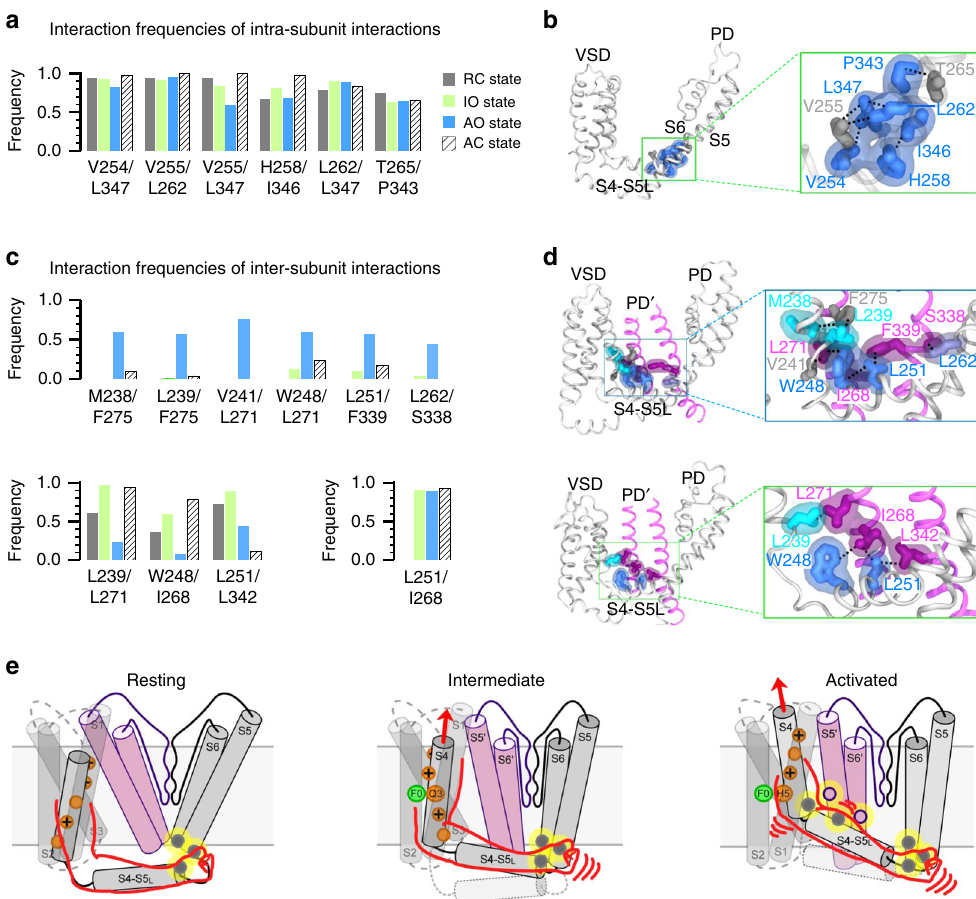
Fig. 5 MD simulation correlates temporal sequence of VSD movement to engagement of the two-stage E – M coupling interactions. a Interaction frequencies of K V 7.1 residue pairs as observed during the MD trajectories for the K V 7.1 RC, IO, AO, and AC models. Frequency threshold of 0.4 or higher is de fi ned as indicative of interaction between two residues (see Methods). b Representations of the IO state model of a K V 7.1 subunit. Inset: enlarged structures of the boxed area. Blue, residues identi fi ed as important for E – M coupling in experiments (Fig. 1c – g); gray: V255 and T265, which were identi fi ed in MD simulations, but for which mutations still show functional currents (Fig. 3c). Residue V255 was found to be important for the AO state E – M coupling (Fig. 3). Each pair of residues is represented by a black dashed line connecting their respective sidechains. c Interaction frequencies of AO model-speci fi c (top), IO model-speci fi c (bottom left), and in both IO and AO models (bottom right) residue pairs during the MD trajectories. d Representations of the AO (top) and IO states (bottom) models of K V 7.1. An entire subunit (in gray) as well as S5' and S6' segments of an adjacent subunit (in purple) are shown with insets of enlarged structures of the boxed area. Residues important for E – M coupling in experiments (Fig. 3) and involved in residue pair interactions in MD simulations are colored similarly as in Fig. 3h: cyan, residues in S4c; blue: S4-S5L, and purple: S5 and S6 from the adjacent subunit. Residues V241 and F275, which were identi fi ed in MD simulations as possibly involved in sidechain interactions but for which mutations did not alter AO states, are colored in dark grey. Each pair of residues is represented by a black dashed line connecting their respective sidechains. e Cartoon schemes illustrating the two-stage hand-and-elbow mechanism of K V 7.1 voltage-dependent activation. Only two neighboring subunits (gray and pink) are shown for clarity. Gating charges on the S4 segment are shown in orange, the hydrophobic plug F0 in the gating charge transfer center is shown in green, and the two sets of interactions are shown as yellow circles. Source data are provided as a Source Data fi